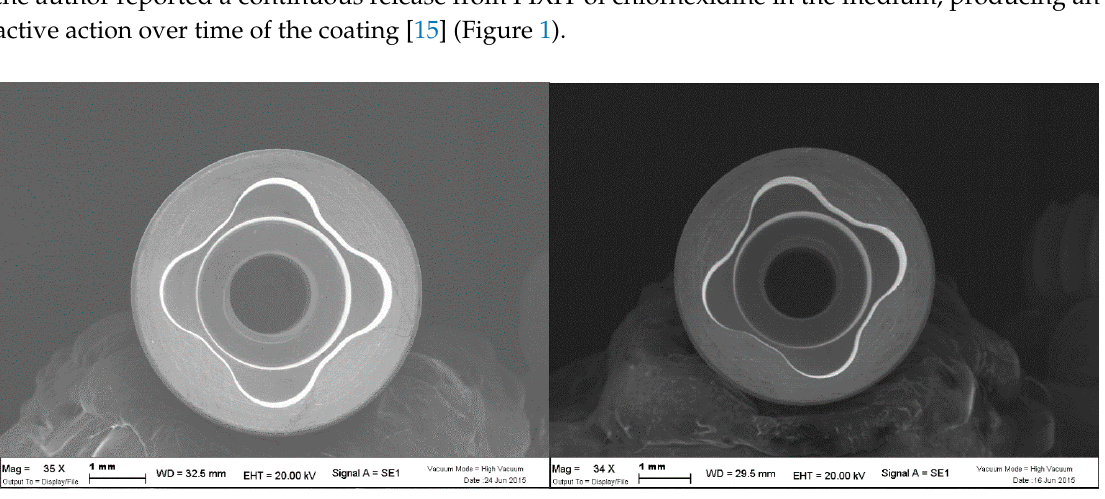
Figure 1. Internal chamber of the fixtures of untreated ( left ) and treated ( right ) with the alcoholic solution containing polysiloxane oligomers and chlorhexidine gluconate at 1% (PIXIT) showing that the coating does not change the internal thickness.